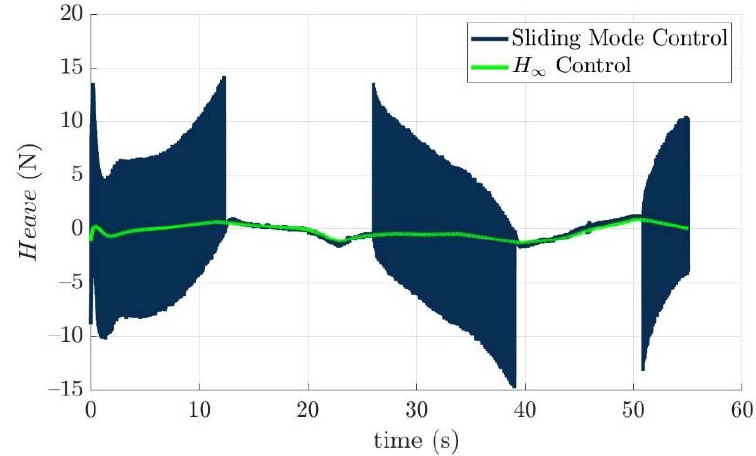
Figure 16. Sway forces of the developed torpedo-like underwater vehicle with respect to the sliding mode control law and the nonlinear H ∞ control law.